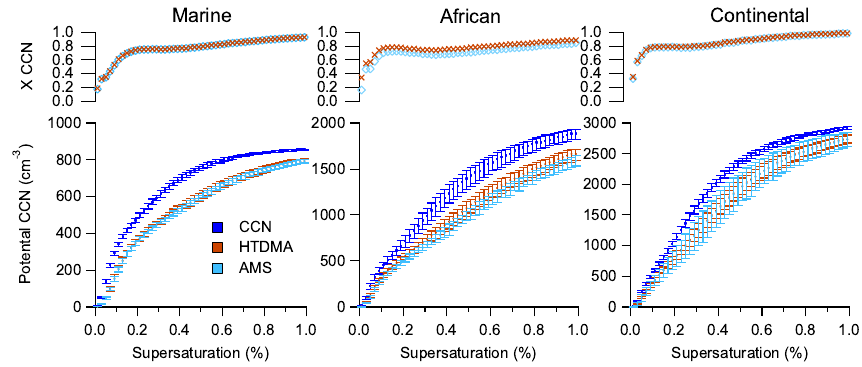
Fig. 8. CCN concentrations as a function of supersaturation for the 3 study periods. The top panels show the fraction of the CCN counter derived CCN concentration predicted from the AMS and HTDMA (X CCN=CCN predicted /CCN measured ). The bottoms panels show the CCN concentrations based on the κ parameterisations derived from the AMS (light blue symbols), HTDMA (brown symbols) and CCN counter (dark blue symbols). The error bars on the AMS and HTDMA derived concentrations represent the 10th and 90th percentile κ values for the respective period. The error bars on the CCN counter derived concentrations represent the range of κ values from the period averaged CCN data.